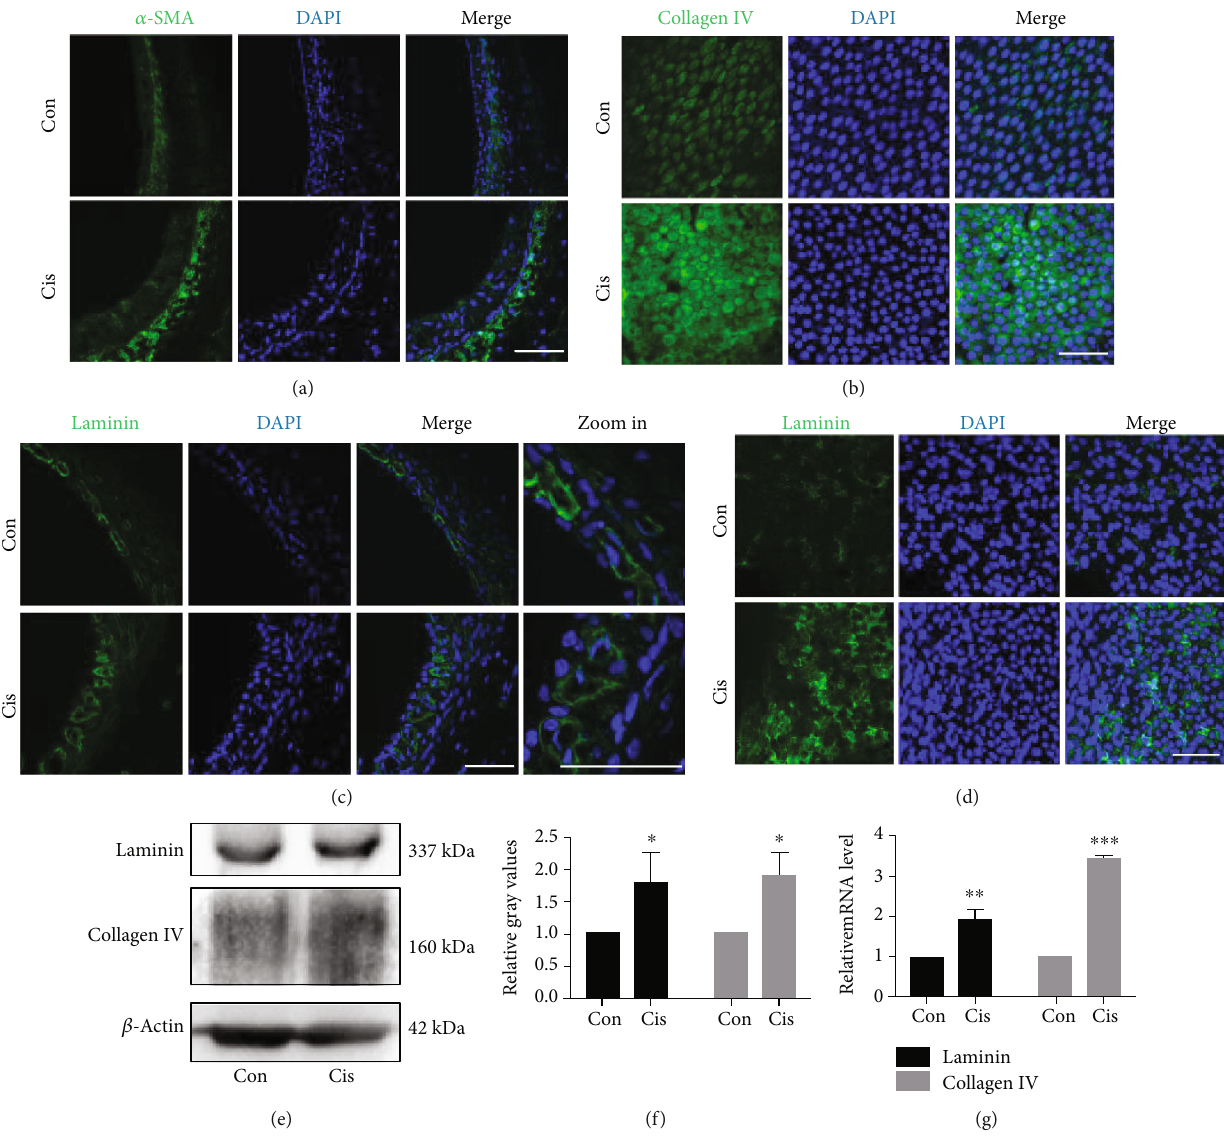
Figure 5: Cisplatin promotes translocalization of α -SMA-positive cells into SV and increases the expression of collagen IV and laminin. (a) Confocal immuno fl uorescence for α -SMA in lateral tissue. Nuclei were stained with DAPI (blue). Scale bars, 100 μ m. (b) The distribution of collagen IV (green) in the MCs by immuno fl uorescence staining. After the treatment of cisplatin, the weak-to-moderate collagen IV signal was found in the SV. Nuclei were stained with DAPI (blue). Scale bars, 100 μ m. (c, d) The distribution of laminin (green) in frozen sections (c) and surface preparation (d) by immuno fl uorescence staining. After the treatment of cisplatin, the expression of laminin increased after cisplatin treatment, blood vessel cavity became rounder, and pericytes migrated away from blood vessels. Scale bars, 100 μ m. (e) Western blot of cell lysates of SV treated with cisplatin. β -Actin was used as a loading control. (g) qRT-PCR shows mRNA for laminin and collagen IV in the SV ( n = 3 ). Con: 0.9% physiological saline; Cis: cisplatin. ∗ p < 0 : 05 , ∗∗ p < 0 : 01 , and ∗∗∗ p < 0 : 001